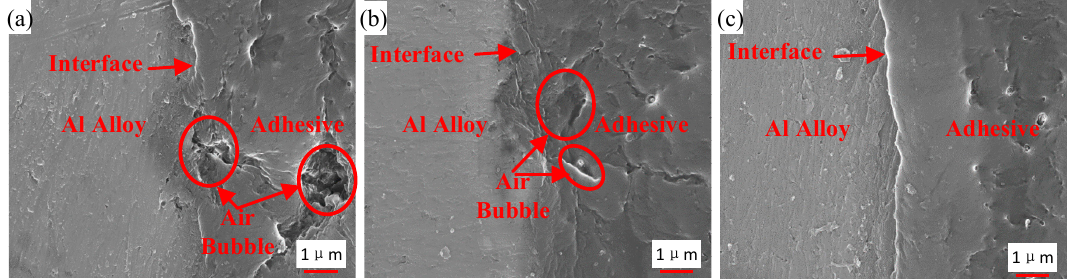
Figure 16. Interface morphology of the samples from ( a ) Group 1, ( b ) Group 2, and ( c ) Group 3.